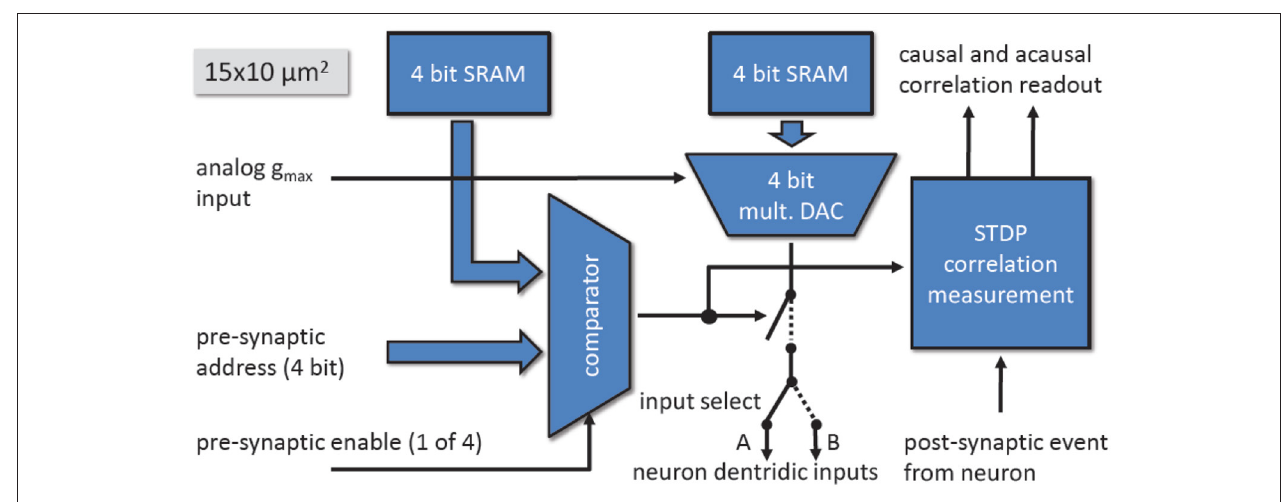
FIGURE 13 | Block diagram of the